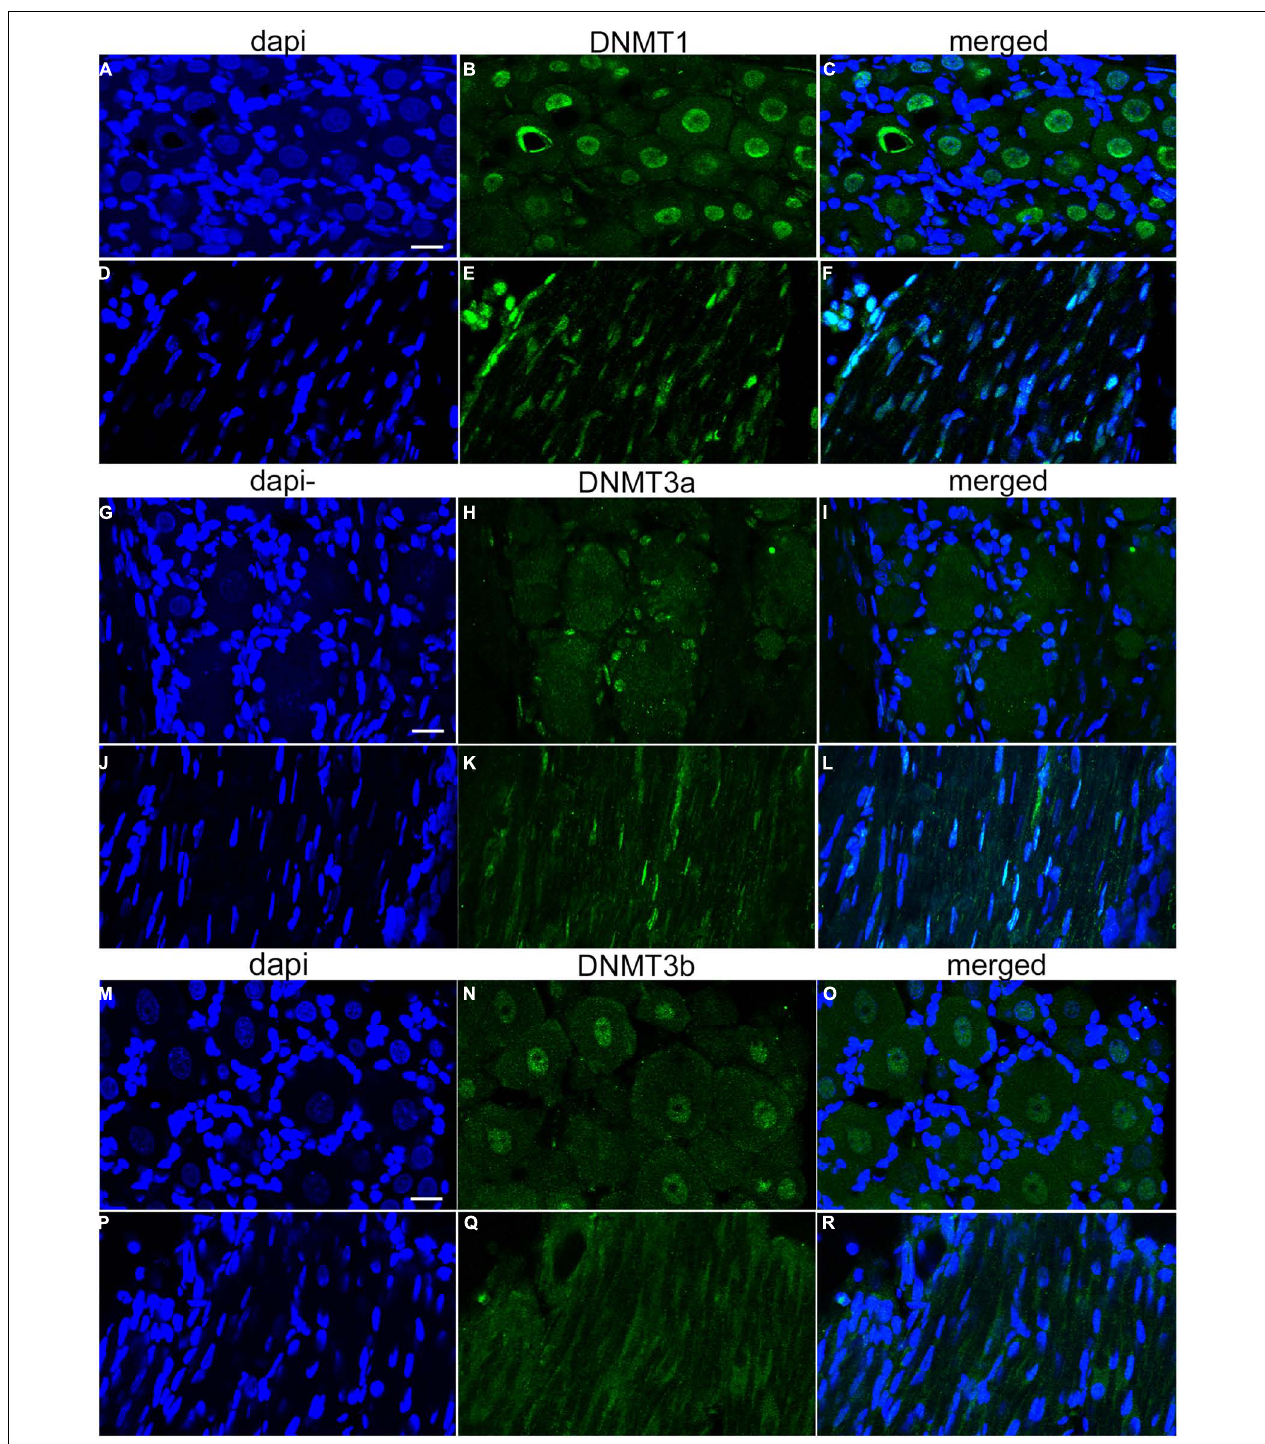
FIGURE 1 | DNA methyltransferase expression in DRG is cell-type specific. 20-micron L4 and L5 DRG sections from control rats aged 5–7 weeks were immuno-labeled with DNMT antibodies as well as incubated with the nuclear labeling dye 4’,6-diamidino-2-phenylindole (DAPI). (A–C) Show robust and ubiquitous labeling of DNMT1 in nuclei of DRG neurons. Notably, there is little expression of DNMT1 detected in the satellite cells surrounding DRG neurons. In addition, widespread overlap of DAPI and